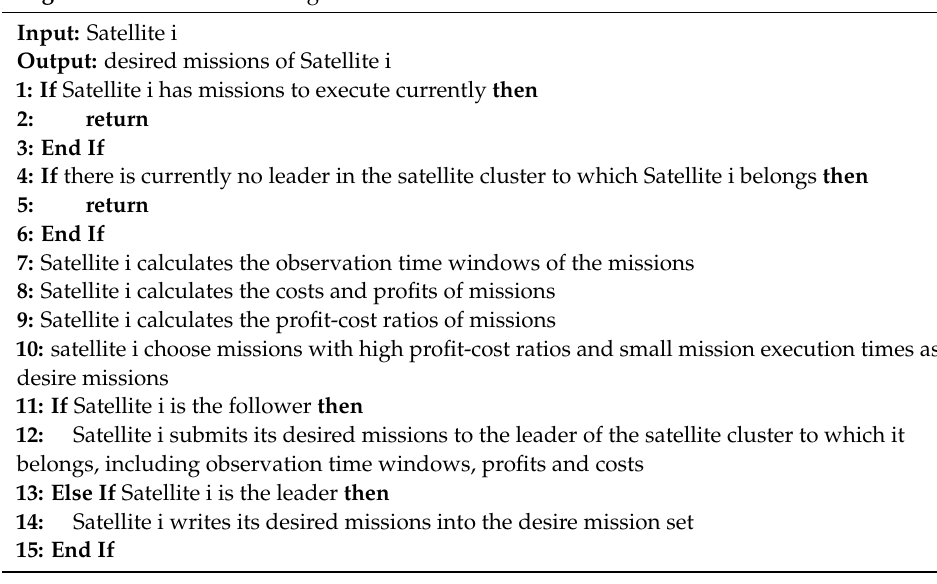
Algorithm 1. The mission origin behavior